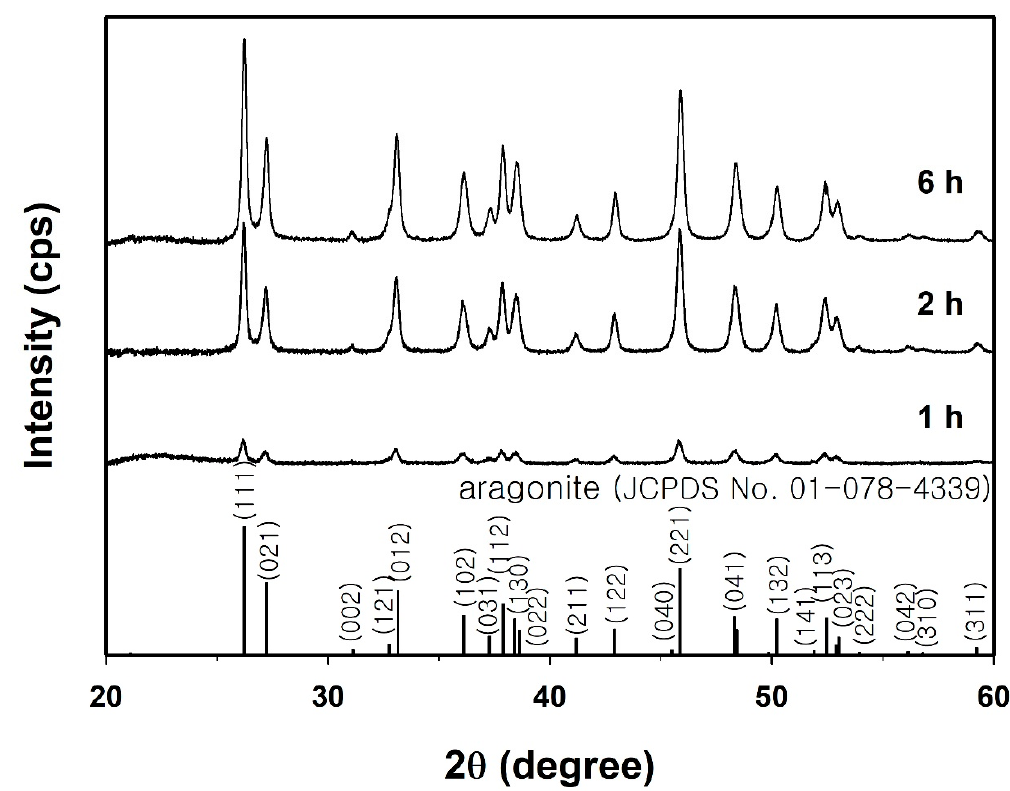
Figure 1. XRD patterns of samples synthesized with different aging times of 1, 2, and 6 h in the absence of organic acids.